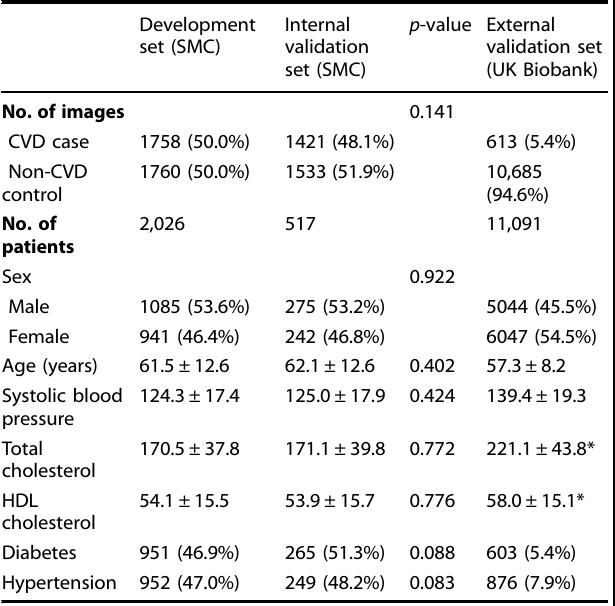
Table 1. Baseline characteristics of the participants.